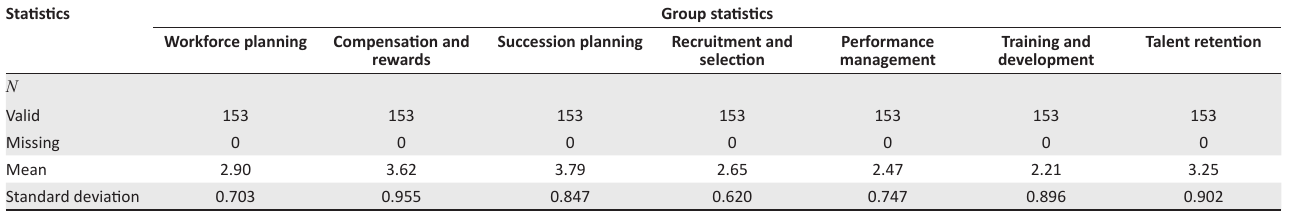
TABLE 4: Means and standard deviations for workforce planning, compensation and rewards, succession planning, recruitment and selection, performance management, training and development and talent retention.